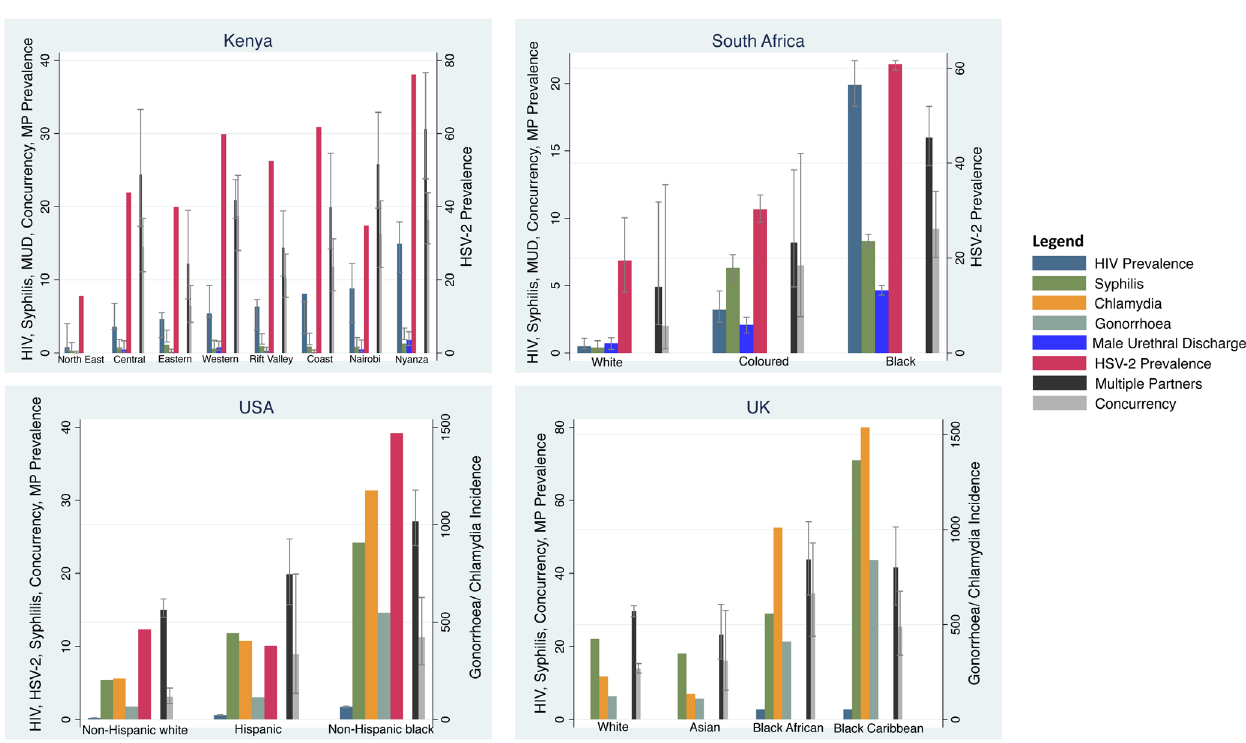
Figure 2. Incidence/prevalence of HIV, HSV-2, chlamydia, gonorrhoea, syphilis, male urethral discharge (MUD), partner concurrency and multiple partnering (MP) by ethnic group in Kenya, South Africa, the United Kingdom and the United States of America. For all countries, HIV, HSV-2, male urethral discharge, multiple partners and concurrency prevalence are reported as percentages. The same is true for syphilis in Kenya and South Africa. In the USA and the UK, chlamydia, gonorrhoea and syphilis are reported as cases per 100 000 per year (Point estimates with 95% Confidence Intervals; see Table 1 for sources of